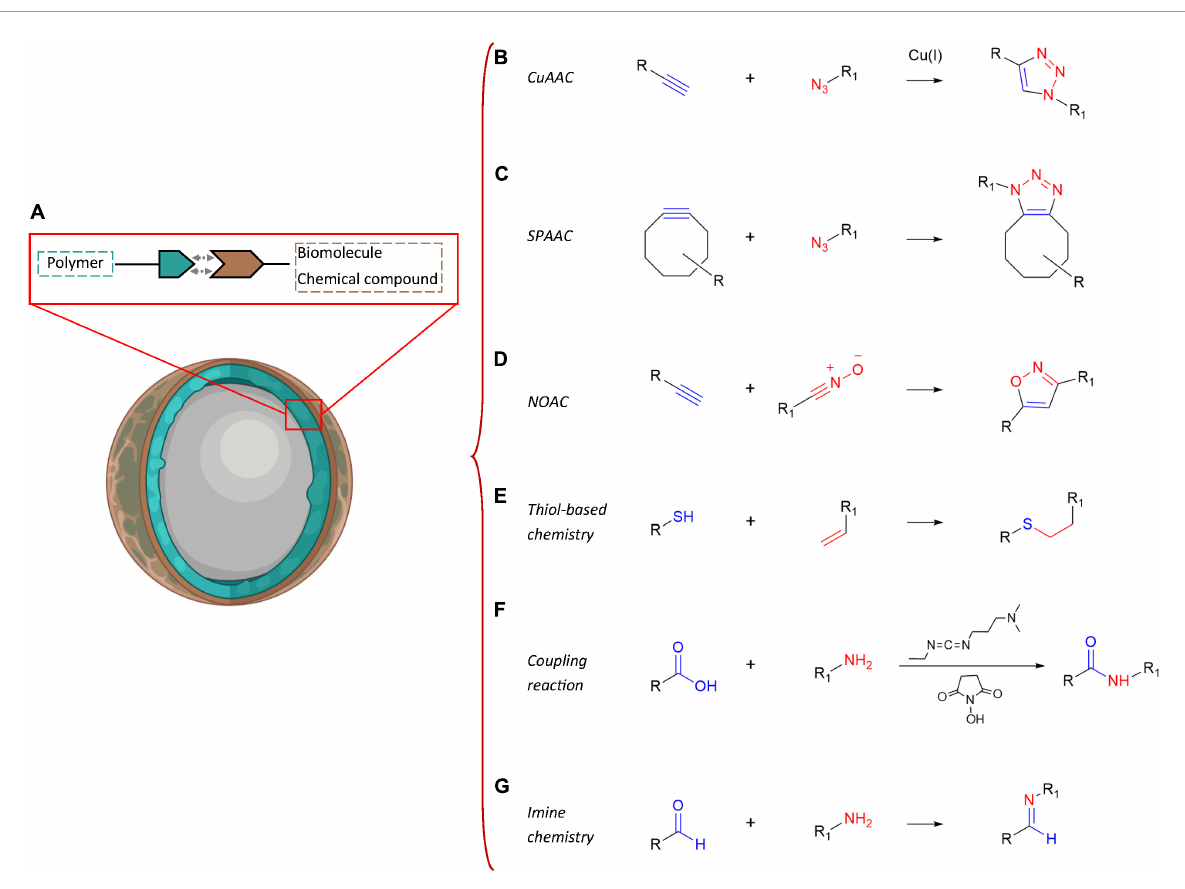
FIGURE4 Summary of the possible chemical functionalization techniques of polymeric NPs. Scheme of the main chemical functionalization strategies of polymeric NPs (A) with biomolecules or specific chemical motifs: (B) copper-catalyzed azide-alkyne cycloaddition (CuAAC) reactions, (C) strain-promoted azide-alkyne cycloaddition (SPAAC) reactions, (D) nitrile oxide-alkyne cycloaddition (NOAC) reactions, (E) thiol-based chemistry, (F) coupling reactions, and (G) imine